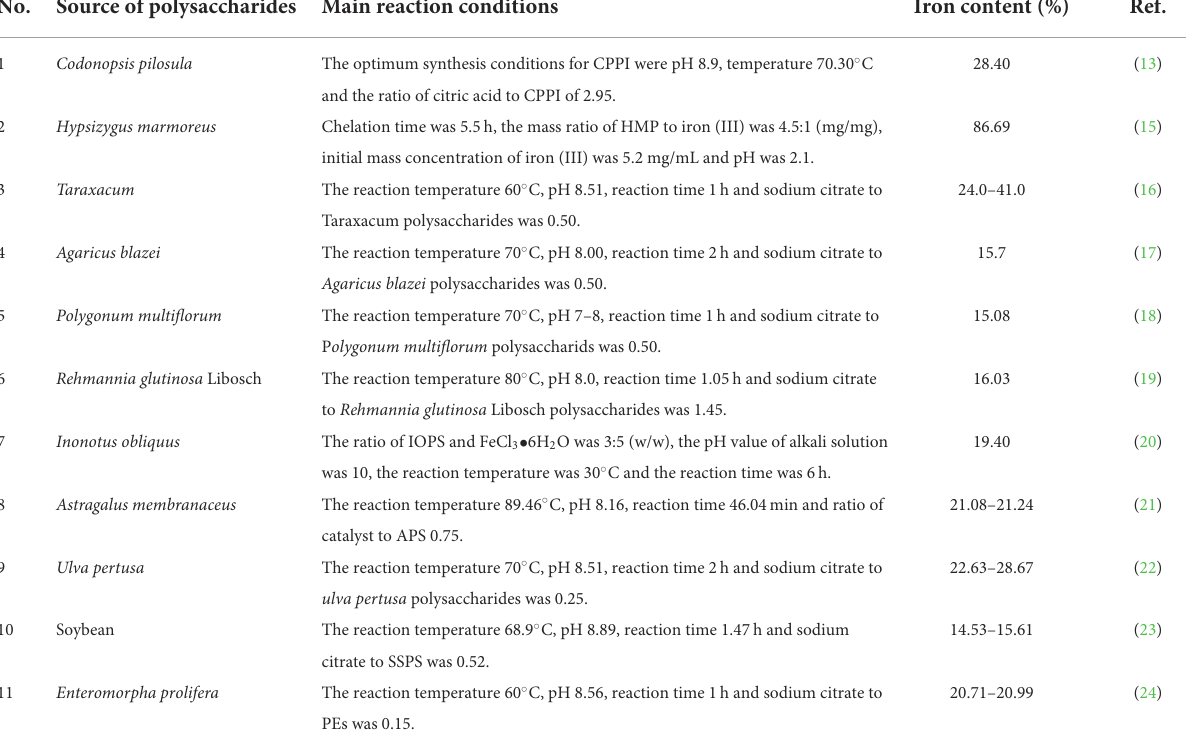
TABLE 1 Main reaction conditions for preparation of PIC by ferric chloride co thermal